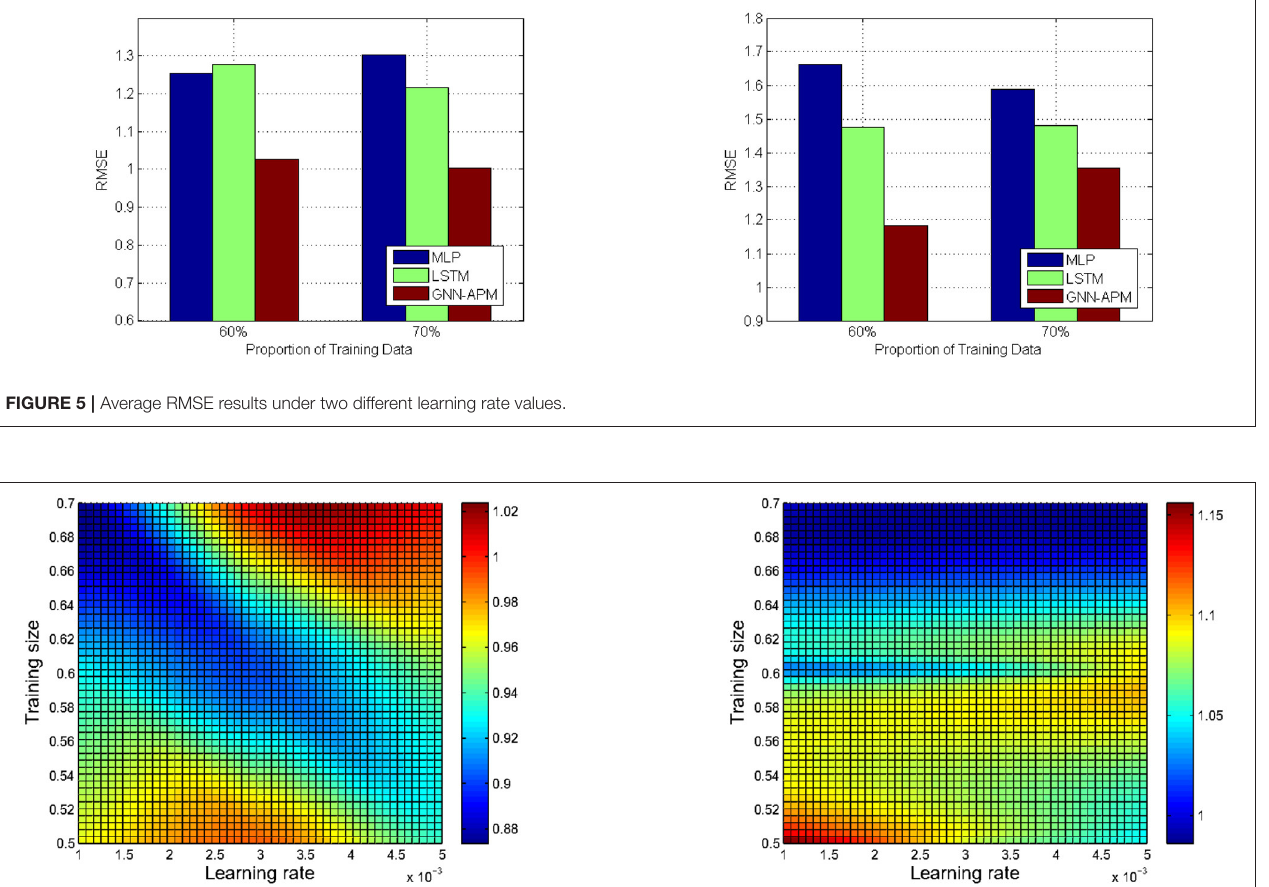
FIGURE 6 | Parameter sensitivity results of the designed GNN-APM concerning MAE and